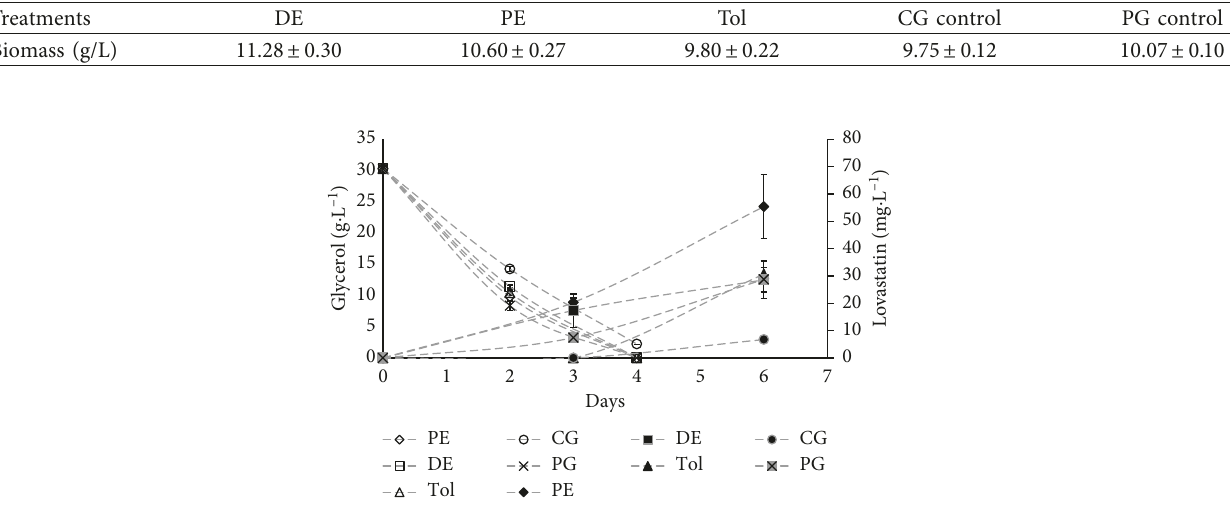
Figure 1: The glycerol consumption and lovastatin production of A. terreus under different substrates. The glycerol consumption is the slowest in CG and the fastest in PG. Lovastatin is consistently the highest under PE pretreatment, while CG produced the lowest lovastatin.